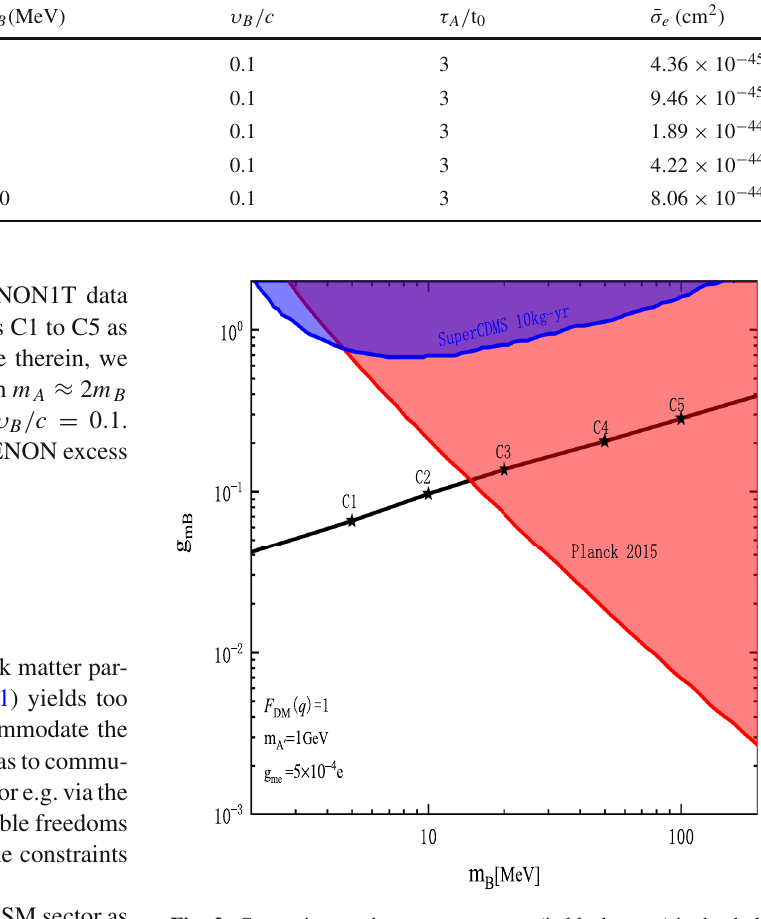
Fig. 2 Constraints on the parameter space (in black curve) in the dark photon model with m A (cid:9) = 1 GeV, g me = 5 × 10 − 4 e and the DM form factor F ( q ) = 1. We have simultaneously shown the SuperCDMS limit [20] (in blue) and the Planck 2015 limit [27] (in red), where the shaded regions are